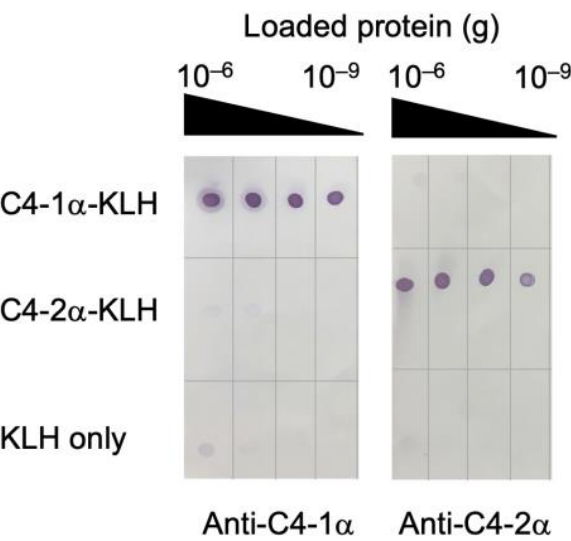
Figure 1. Dot-blotting analysis of anti-C4-1 α and anti-C4-2 α . KLH conjugated with the antigen peptides and KLH alone were loaded onto PVDF membranes at different doses (1, 10, 100, and 1000 ng) and incubated with affinity-purified antibodies against C4-1 α and C4-2 α peptides. The antigen dots were visualized with peroxidase-conjugated secondary antibody and 4-chloro-1-naphthol substrate. In Figure 2, anti-C4-1 α detected a 190 kDa band in the fractions corresponding to a molecular mass of about 200 kDa in the gel-filtration of carp serum protein, suggesting that the antibody is highly specific to carp C4-1. On the other hand, anti-C4-2 α did not give a positive band against any